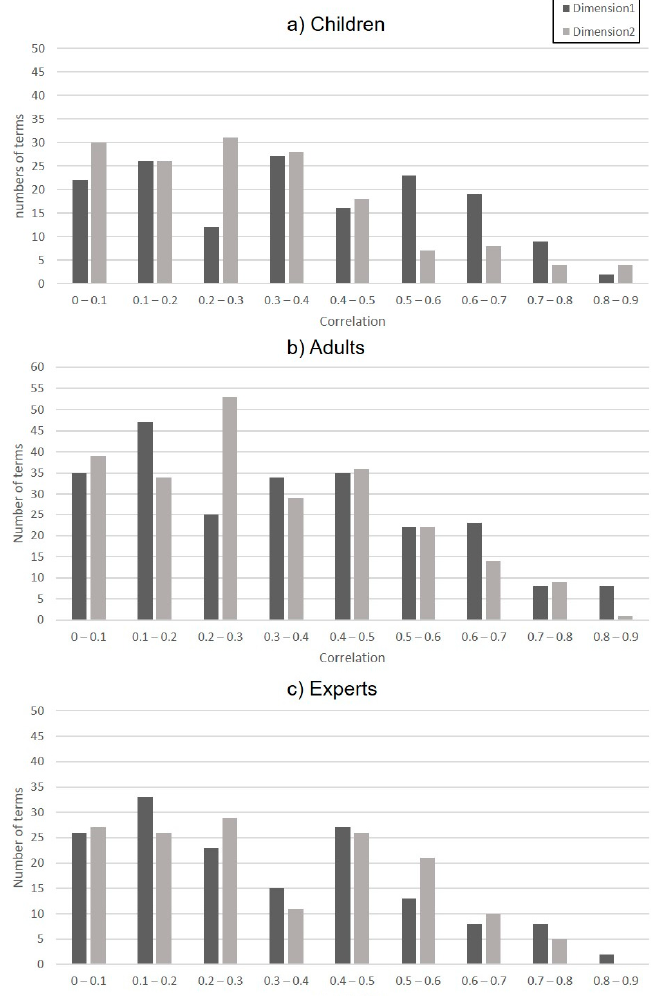
Figure 2. Correlation of ( a ) children, ( b ) adults, and ( c ) expert observer terms with dimension 1 and dimension